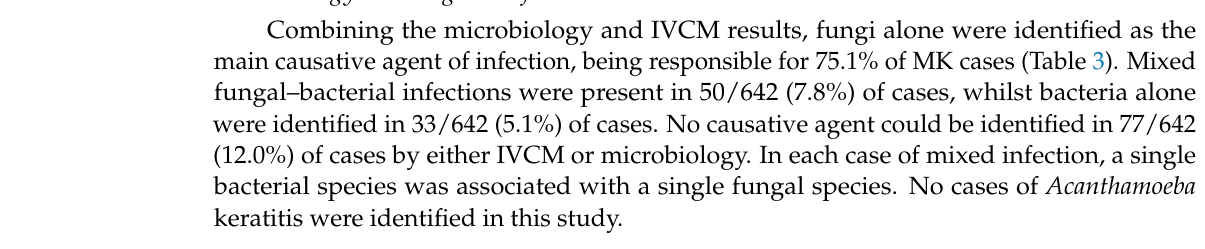
Table 3. Aetiology of microbial keratitis with corresponding results of